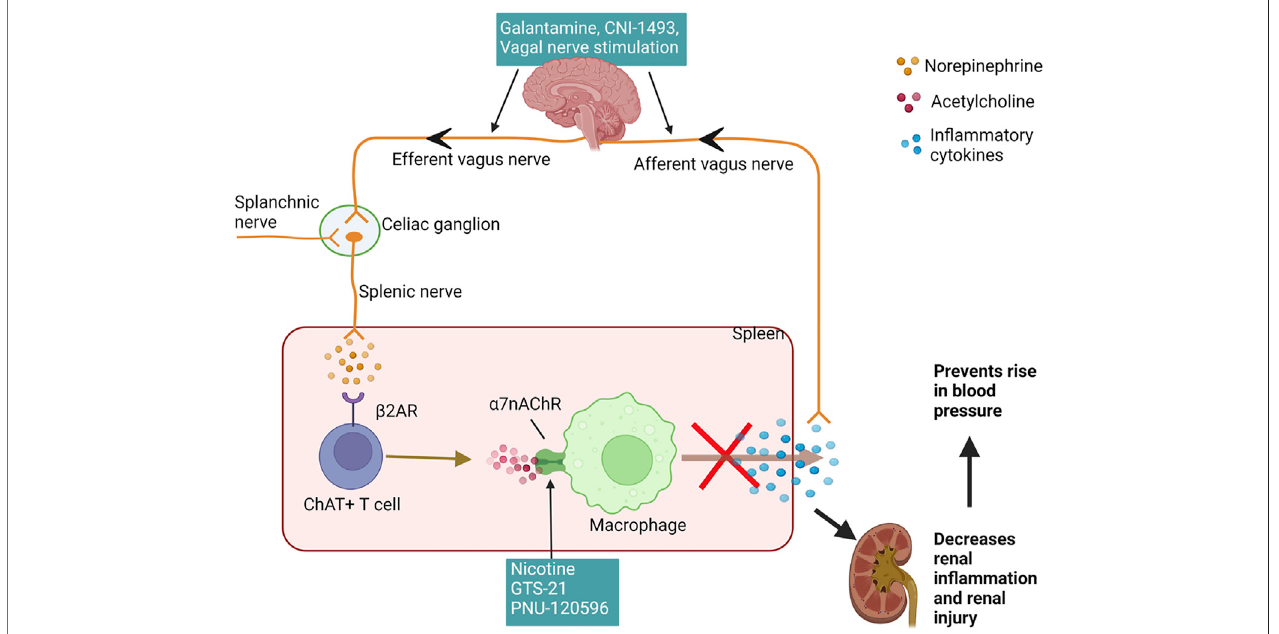
FIGURE 2 | Cholinergic anti-in fl ammatory pathway reduces renal in fl ammation and hypertension: The afferent vagus nerve detects in fl ammatory cytokines and relays this information centrally to increase the efferent vagus, which synapses on the celiac ganglion and activates the splenic nerve. Another possible mechanism for activation of splenic nerve is via the splanchnic nerve. The splenic nerve has sympathetic fi bers and stimulates splenic ChAT + T cells to synthesize and secrete acetylcholine, which acts upon various immune cells in the spleen, including macrophages, to inhibit the production and release of in fl ammatory cytokines. A reductioninsplenicin fl ammationandproin fl ammatorycytokinesincirculationdecreasesrenalin fl ammationandrenalinjurypreventingtheriseinthebloodpressure.The efferent vagus nerve can be stimulated using pharmacological agents galantamine and CNI-1493 or direct electrical stimulation. GTS-21 and nicotine, agonists of the α 7nAchR and PNU-120596, positive allosteric modulator for this receptor leads to activation of this receptor to inhibit the cytokine release from immune cells. ( β 2AR — beta 2 adrenergic receptor; ChAT + T cells — choline acetyltransferase positive T cells; α 7nAchRs — alpha seven nicotine acetylcholine receptors). Created with